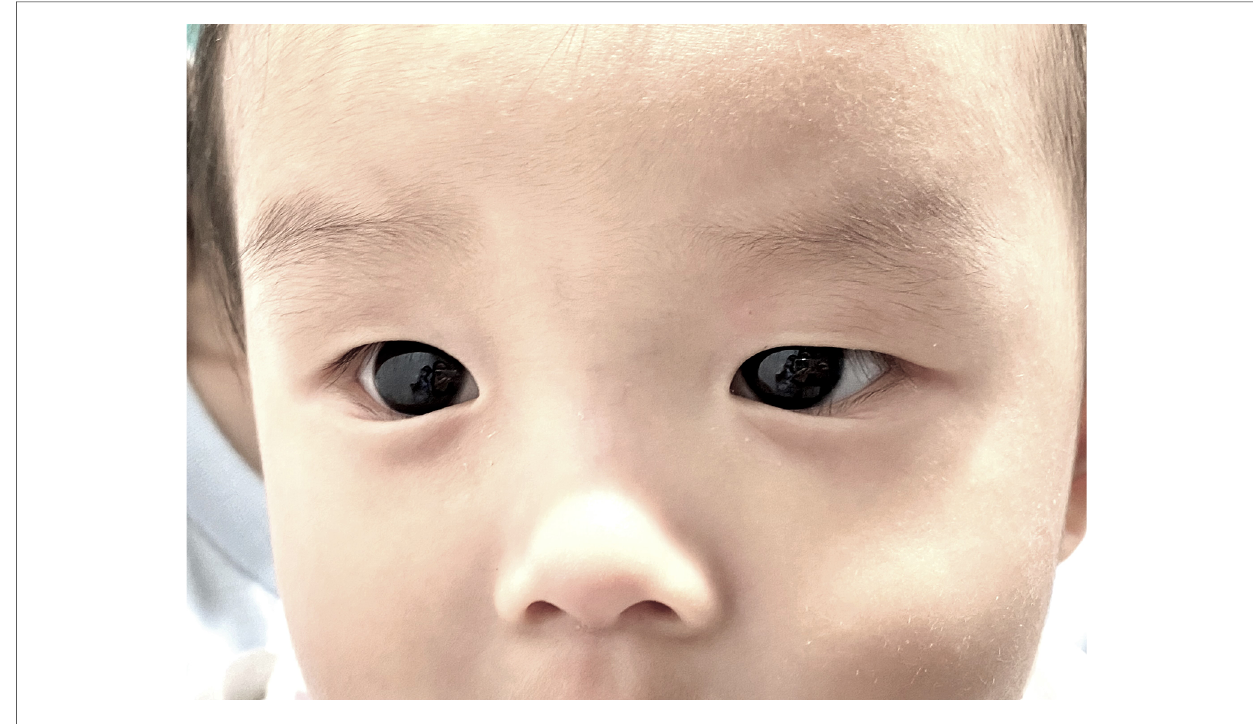
FIGURE 2 Eye examination 2 weeks after SARS-CoV-2 infection. Clear corneas without bluish discoloration are